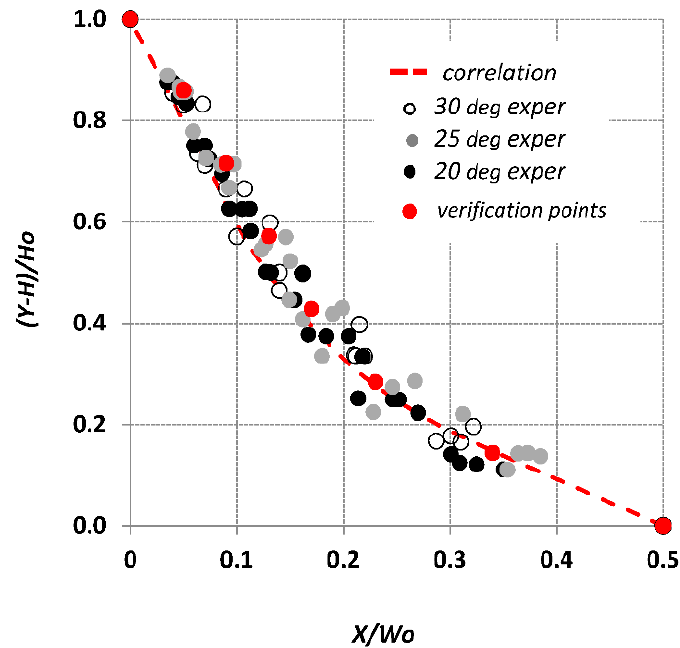
Figure 10. Comparison of the shape of the interface calculated by Equation (6) with relevant experimental data.